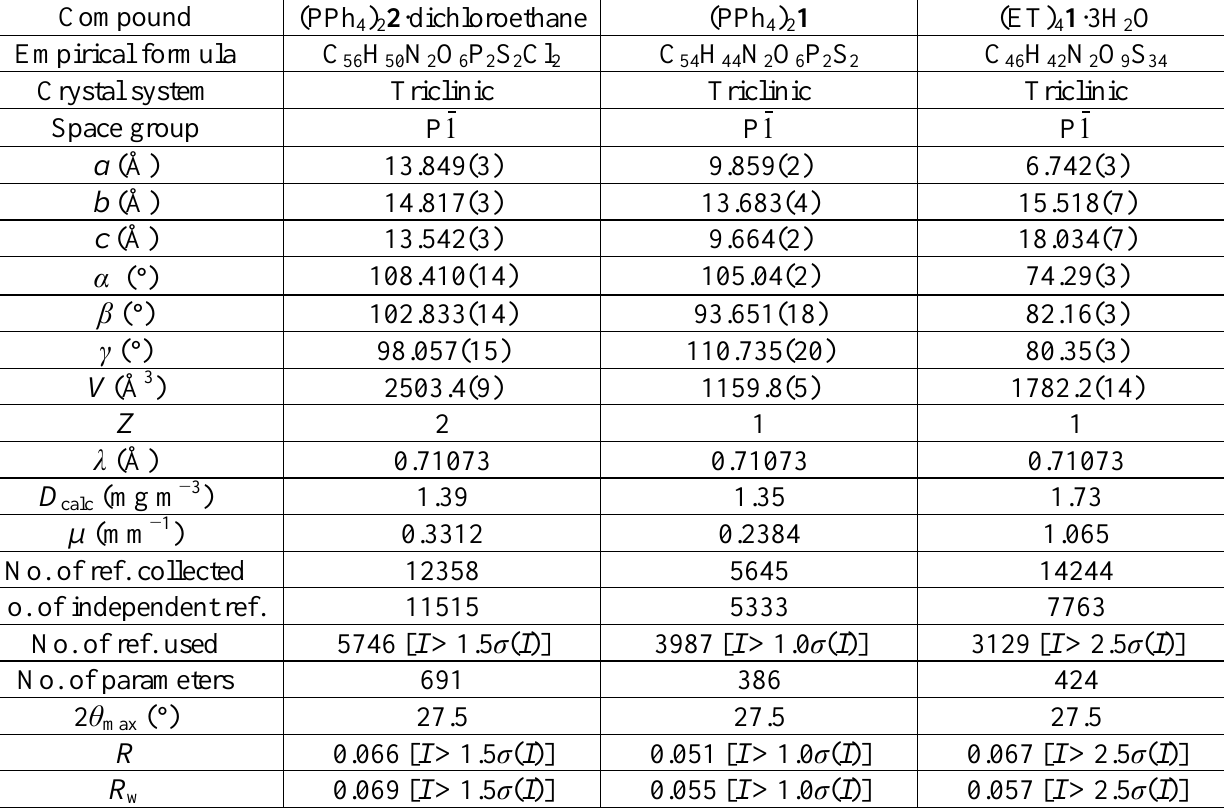
) 2 ·CH ClCH Cl, (PPh 4 2 2 2